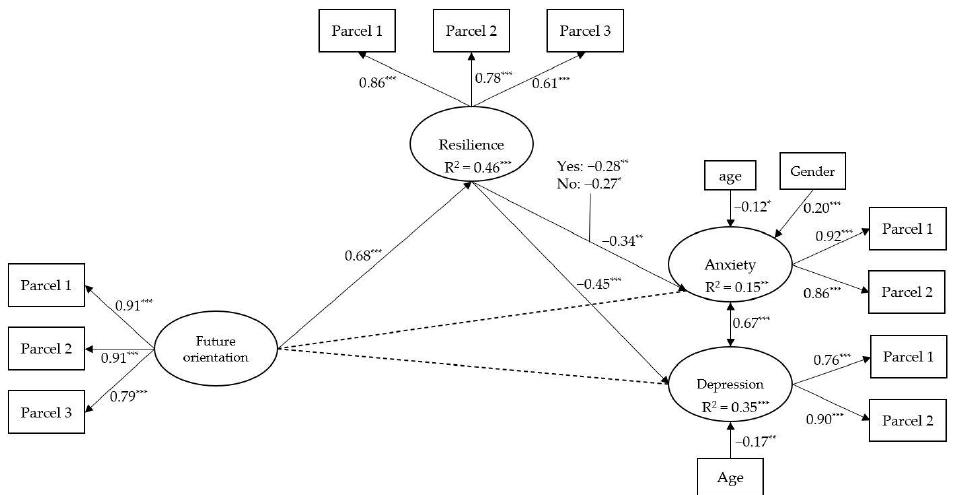
Figure 1. Results of the SEM model. All the values are standardized. The dashed lines indicate non-significant paths. Latent factors are presented in the circle; measured variables (parcels) are presented in the rectangles. All the analyses were controlled for gender (1 = male, 2 = female) and age. Note. * p < 0.05. ** p < 0.01. *** p < 0.001.